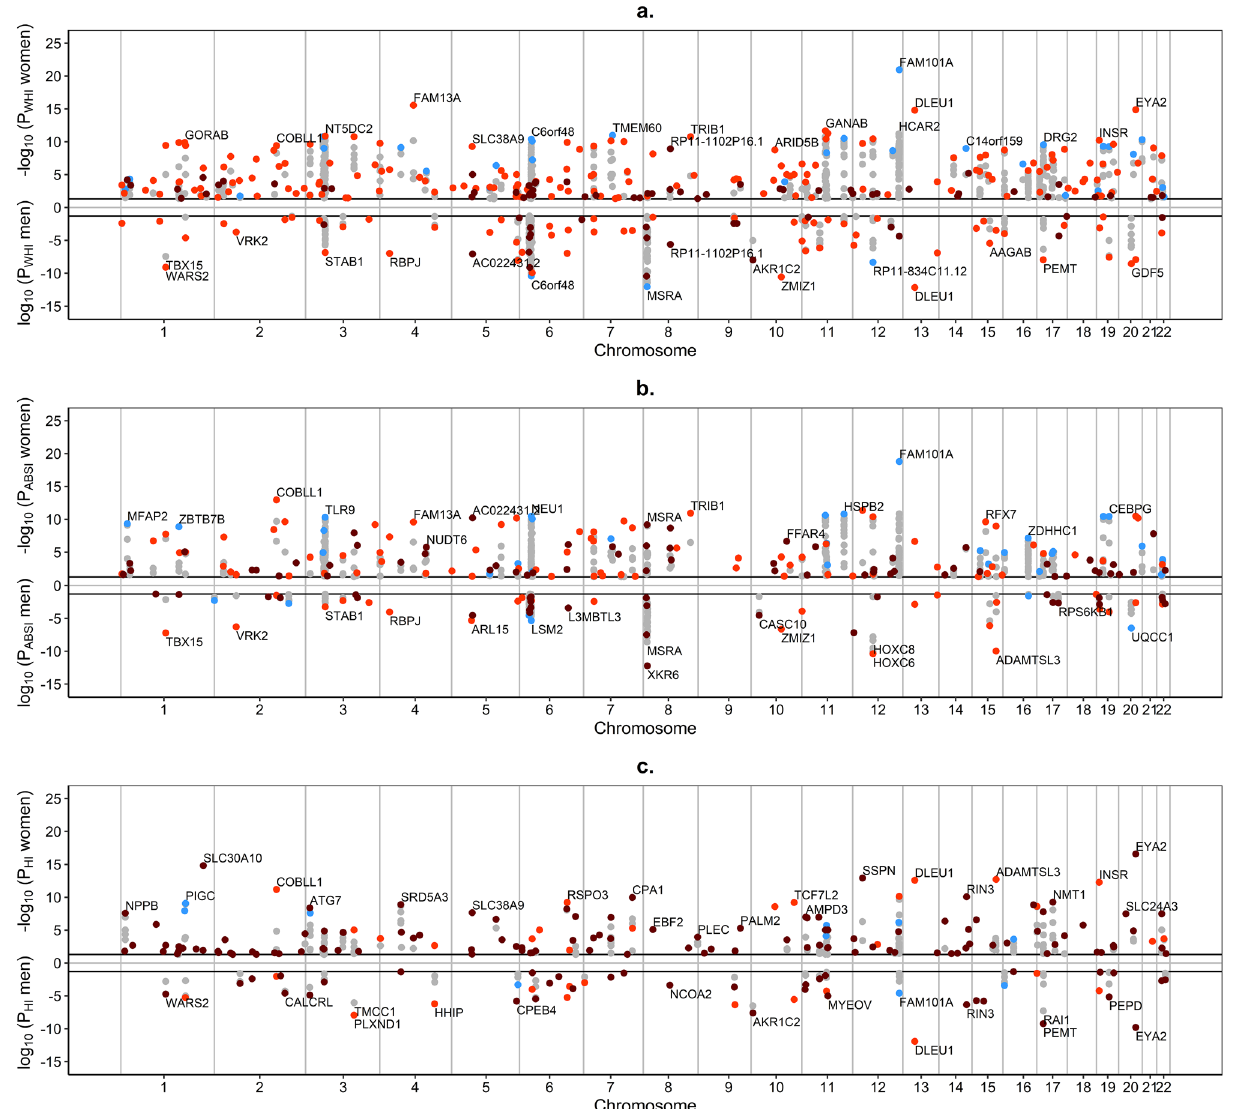
Figure 3. Miami plots of significant genes identified for allometric body-shape indices in women and men. ( a ) waist-to-hip index calibrated for UK Biobank participants ( WHI UKB ); ( b ) a body shape index calibrated for UK Biobank participants (ABSI UKB ); ( c ) hip index calibrated for UK Biobank participants (HI UKB ); P- P -values were derived from MAGMA v1.08 employed in FUMA v1.3.6a and were adjusted with Bonferroni correction for 19,088 protein-coding genes; SNP-single nucleotide polymorphism; horizontal lines-correspond to P = 0.05 after Bonferroni correction. Significant genes within 250 kb window were consolidated in genomic risk regions represented by a lead gene. All significant genes are shown in grey, lead genes are colour-coded as follows: (grey circle)-significant genes; (dark red circle)-novel genomic risk region identified in the current study, with no previously reported significant gene; (orange circle)-genomic risk region with a previously reported lead gene; (cyan circle)-genomic risk region including a previously reported significant gene (not the lead gene). Genes identified for allometric body-shape indices in the current study were matched against genes reported in the NHGRI-EBI GWAS Catalog 11 (https:// www. ebi. ac. uk/ gwas/ home, accessed on 07/04/2021) in association with the corresponding traditional body-shape index (with or without adjustment for body mass index, BMI), i.e. the waist-to-hip ratio for WHI UKB (catalogue sets EFO_0004343, EFO_0007788, EFO_0004302); waist circumference for ABSI UKB (EFO_0004342, EFO_0007789, EFO_0004302); hip circumference for HI UKB (EFO_0005093, EFO_0008039,